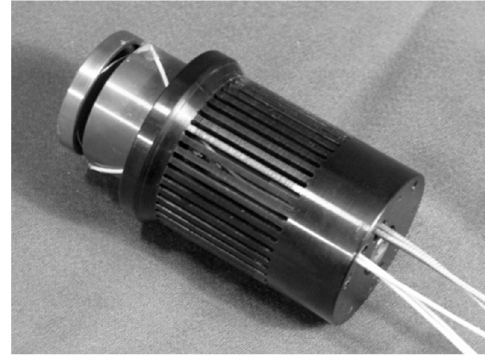
Figure 4. The smart actuator integrated into the mechatronic module.